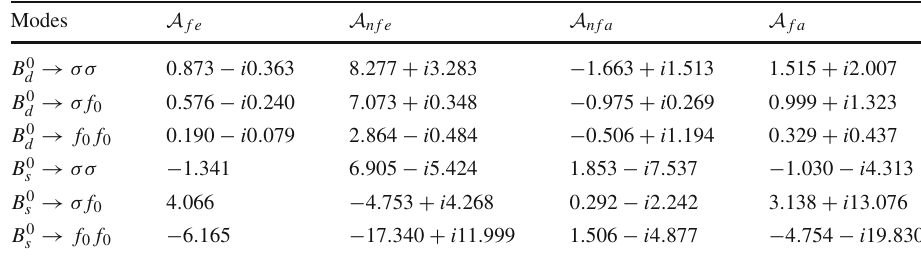
Table 1 The factorization decay amplitudes (in units of 10 − 3 GeV 3 ) of the → σσ,σ f , f B 0 0 0 f 0 decays d , s with the mixing angle ϕ ∼ 25 ◦ in the PQCD approach at leading order, where only